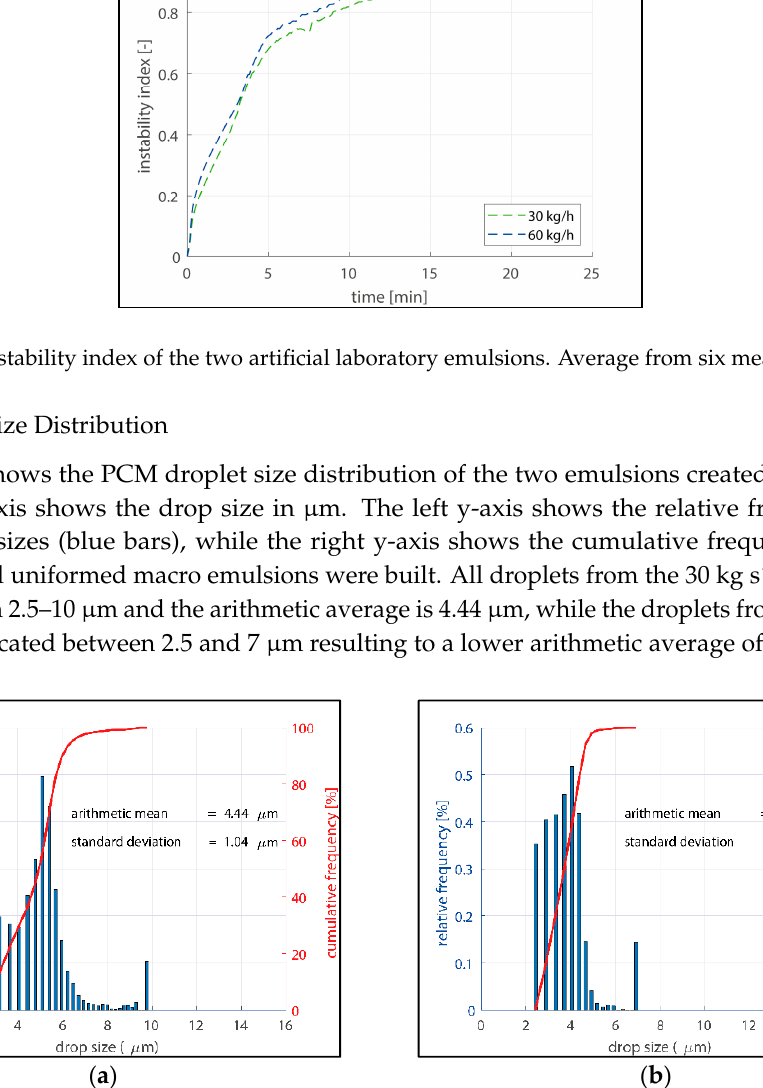
Figure 7. Instability index of the two laboratory emulsions and the reproduction emulsion with a shear time of 7 s. Figure 8 shows the droplet size distribution of the reproduced emulsion with a shear time of seven seconds. Compared to the emulsion from the laboratory (see Figure 6) there are some noticeable differences. All drops are situated between 1 and 15 µm. This means that the reproduced artificial emulsion shows broader drop size distribution compared to the emulsion from the DCLHS setup. The smallest drops have a size of 1 µm compared to the drops of 2.5 µm from the laboratory emulsions, while the largest ones have a size of 15 µm instead of 10 µm or 7 µm measured in the DCLHS emulsion. The smaller drops reduce the arithmetic average down to 2.98 µm. Nevertheless, the majority of the drops fall in the same area size range as in the original emulsion. Around 80% of the drops from the laboratory emulsion and about 60% of the drops from the artificial emulsion are in the range of 3–7 µm.